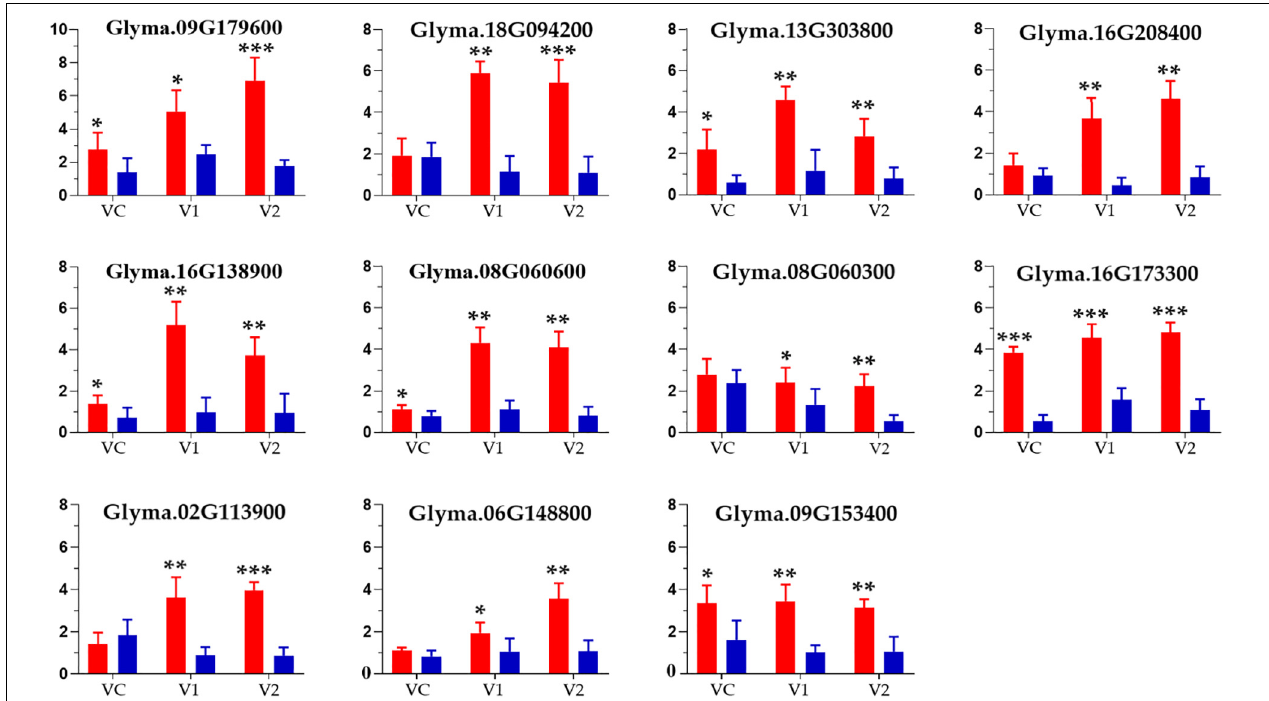
FIGURE 5 | Relative expression levels of eleven candidate genes in phenotypically different root samples from the spring soybean at three seedling stages analyzed via qRT-PCR. The red and blue bars indicate the mean expression level (for four samples) of genes in high and low branching number accessions at VC, Vl and V2 stages, respectively; ***, **, and * specify the significance at the level of P < 0.001, P < 0.01, and P < 0.05,